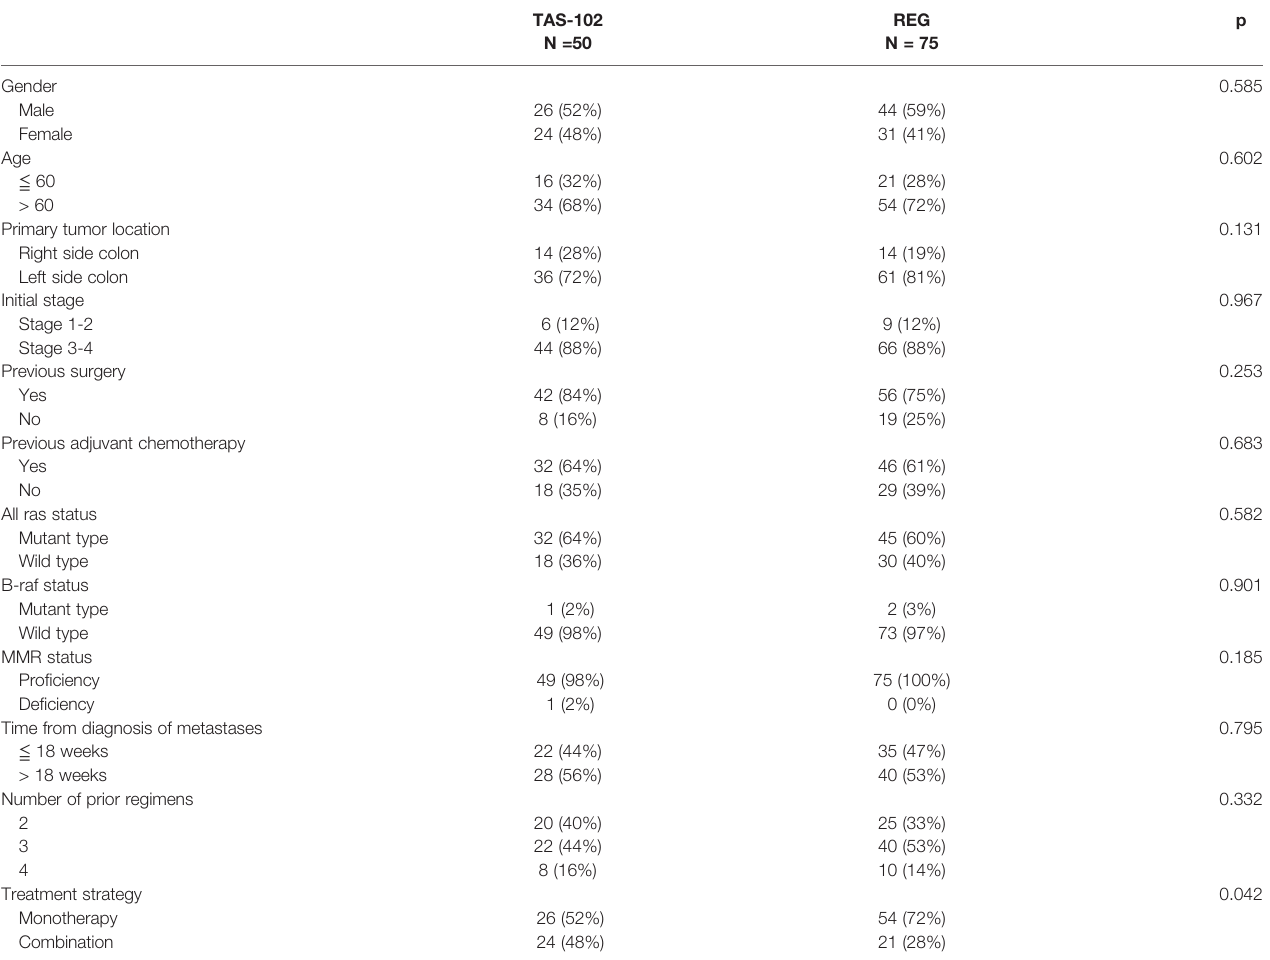
TABLE 1 | Baseline characteristics of patients with mCRC treated with TAS-102 or